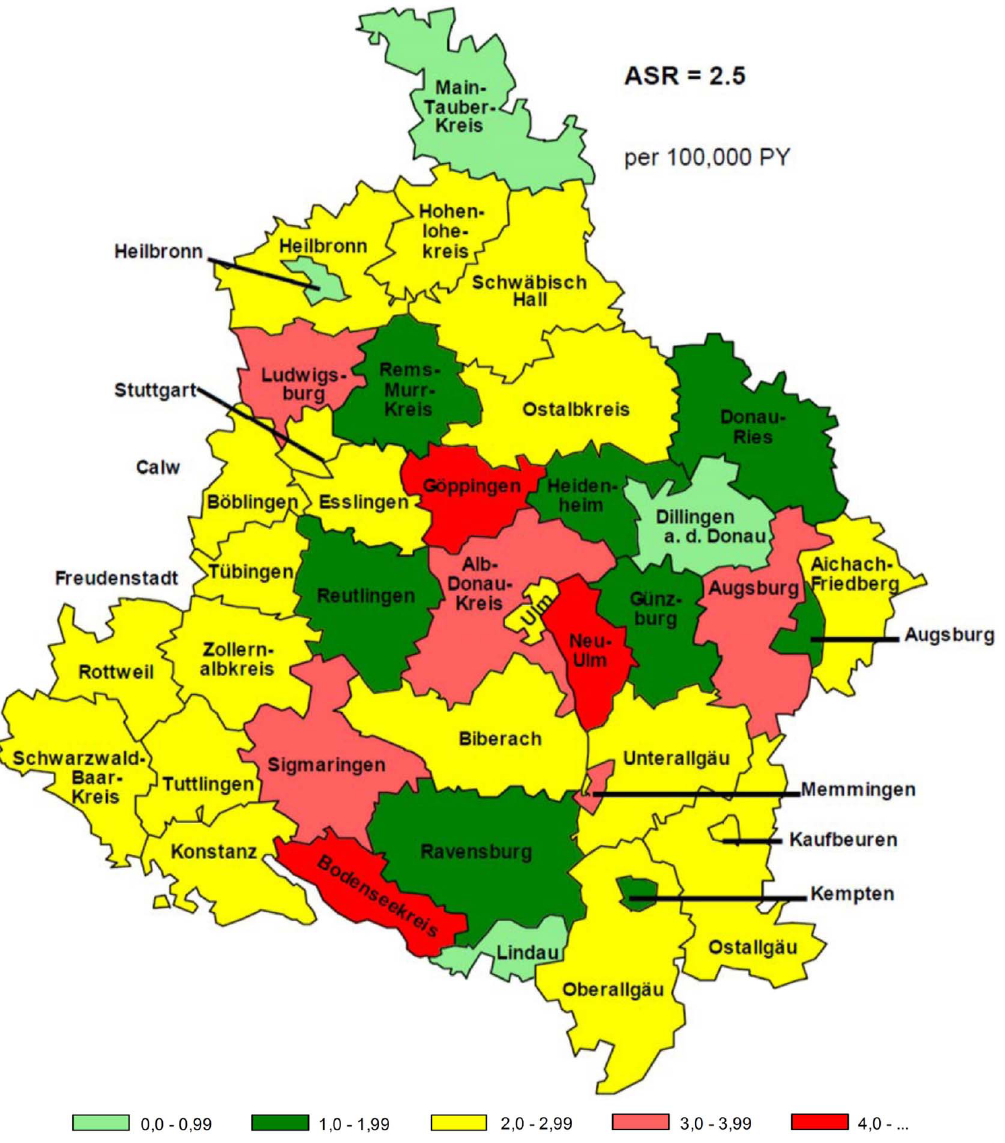
Figure 1. Comparison of age standardized incidence rates of ALS registry data at county level with the exact European populations. As displayed in Fig. 1 , using the exact EU population, the highest ASR was observed in the county Bodenseekreis with 4.4 per 100,000 PY and the lowest with 0.6 per 100,000 PY in the county Lindau. With other EU standard populations, other high incidence counties disappeared (e.g. Go¨ppingen with the old standard population of 1976).